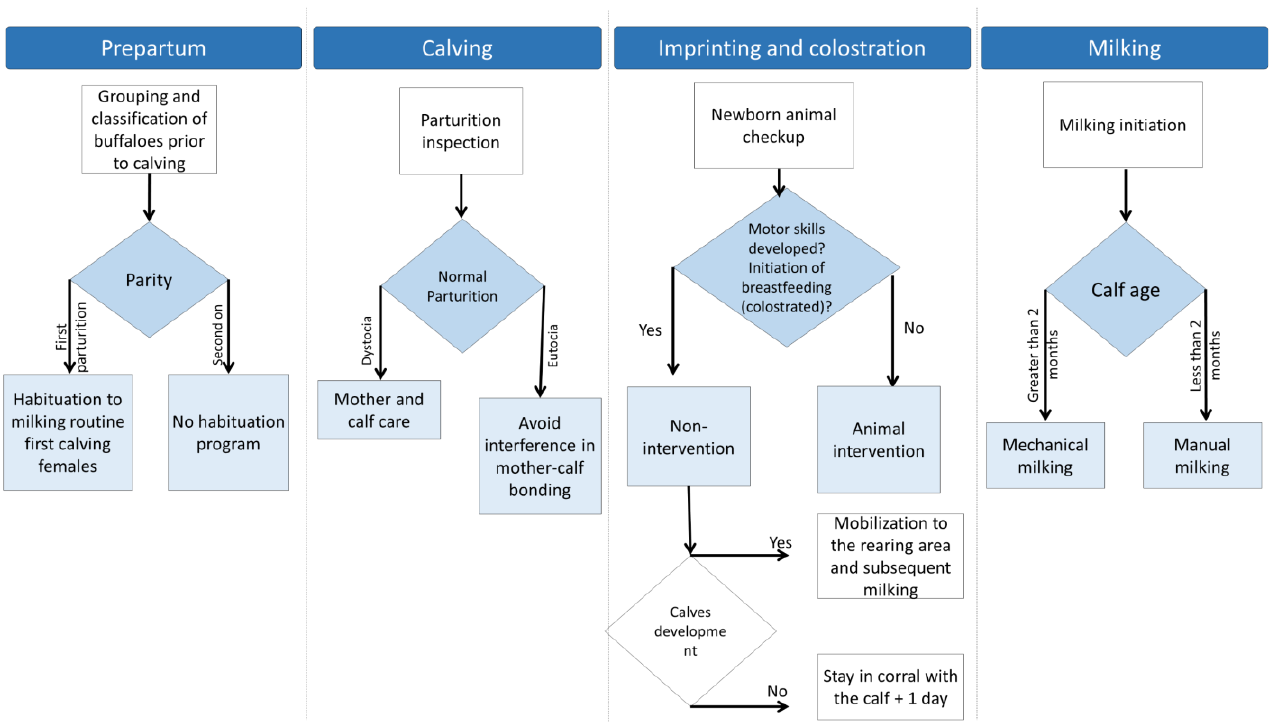
Figure 6. Flow diagram of the prepartum, calving, imprinting, colostrum, and milking processes in the dual-purpose buffalo production system in Mexico’s tropical wetlands.